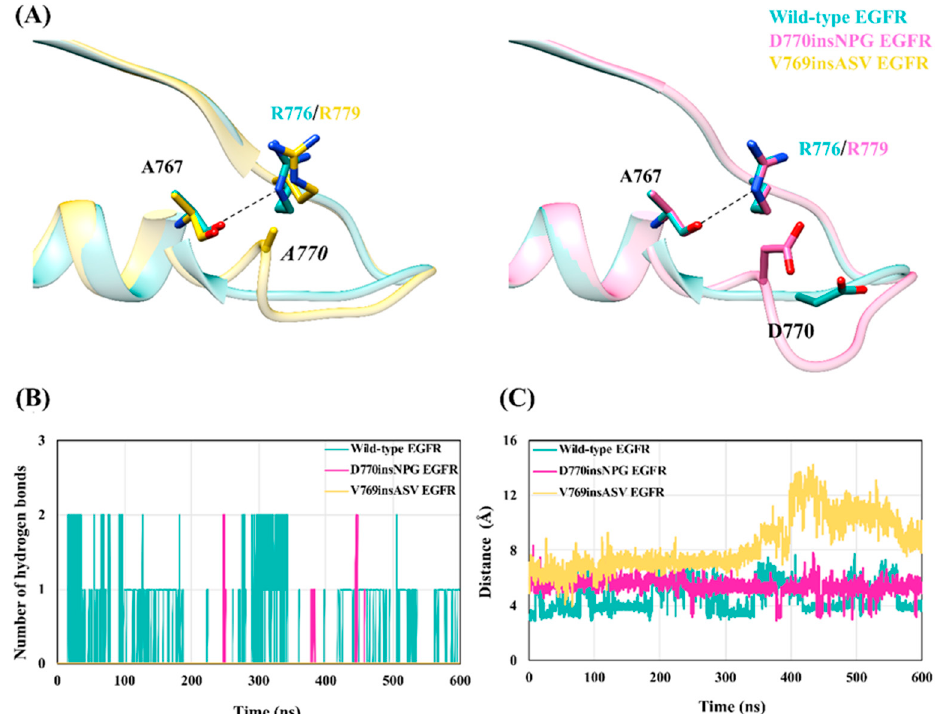
Figure 11. The EGFR D770insNPG and V769insASV insertion mutations may block interaction between Ala767 and Arg776 (wild type)/Arg779 (mutant) that helps maintain the inactive state. ( A ) Superposed starting structures (left) of wild-type and V769insASV EGFRs and disposition of Ala767 and Arg776/Arg779, and the inserted Ala770 . Ala770 wedges between Ala767 and Arg779, preventing the formation of the hydrogen bond between the two residues. Superimposed starting structures (right) of the wild-type and D770insNPG inactive EGFRs: Asp770 in the insertion mutant is oriented close to Arg779 in comparison to wild-type EGFR. Hence, Asp770 would interfere with the optimal placement of Arg779 to interact with Ala767. ( B ) The number of hydrogen bonds formed between the oxygen atom of Ala767 and the guanidium group of Arg776/Arg779 during the simulations of the wild-type and insertion mutant inactive EGFRs. ( C ) The distance between the main-chain oxygen atom of Ala767 and the C ζ side-chain atom of Arg776/Arg779 during the wild-type and mutant